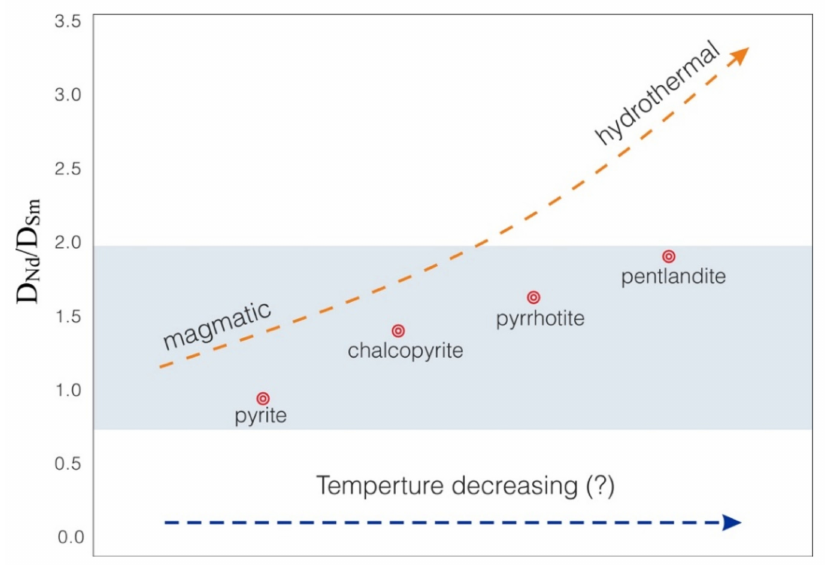
Figure 6. D Nd /D Sm ratio trend in the pyrite–chalcopyrite–pyrrhotite–pentlandite sequence. Higher values of this ratio are found for epigenetic or hydrothermal ores. This may be due to the hydrother- mal processes of sulfide redeposition or the influence of a late fluid with different geochemical characteristics. An increase in the D Nd /D Sm ratio is also likely associated with a melt temperature decreasing and can be used to reconstruct the sequence of sulfide crystallization. Dotted arrow indicates an estimated decreasing trend in